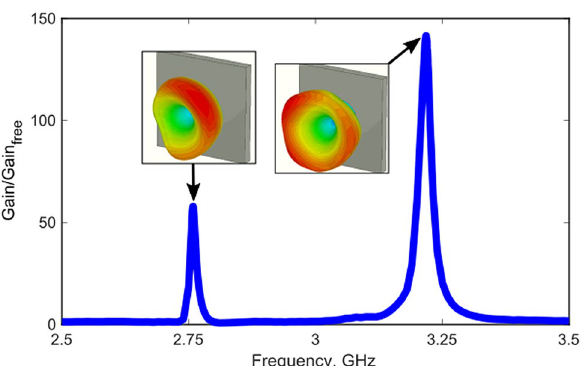
Figure 5. Normalized gain spectra for the pair of chosen frequencies. The normalization is the ratio of gain, obtained for the device with circular array of spheres and without it. Insets—far-field radiation